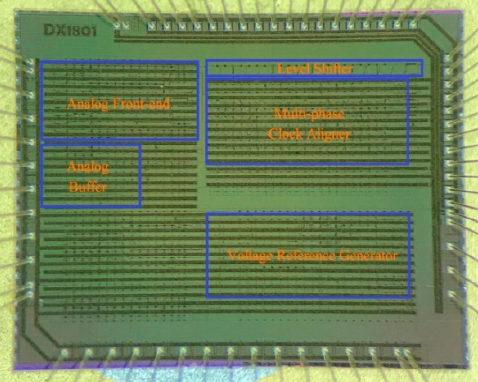
Figure 7. Micro-photo of the readout ASIC.